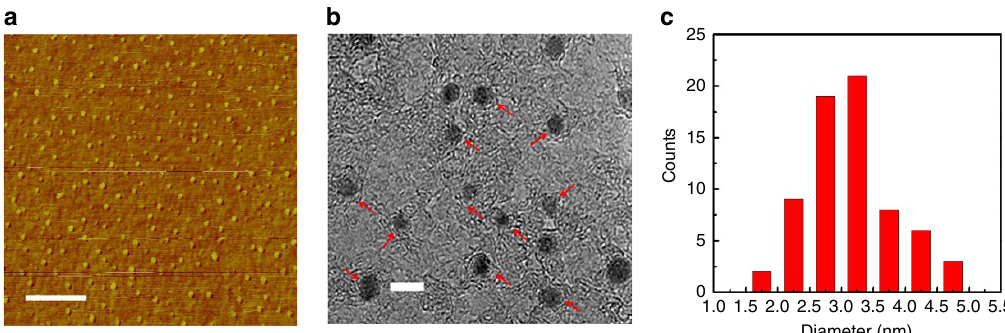
Figure 2 | Morphology and diameter distribution of the Co nanoparticle partially coated with carbon. Typical ( a ) AFM and ( b ) TEM images of the Co nanoparticles partially coated with carbon, showing that the nanoparticles are monodispersed and uniform in size. The red arrows indicate Co nanoparticles partially coated by a carbon layer. Scale bar, 400nm ( a ) and 5nm ( b ). ( c ) A histogram showing the diameter distribution of the nanoparticles based on TEM observations.